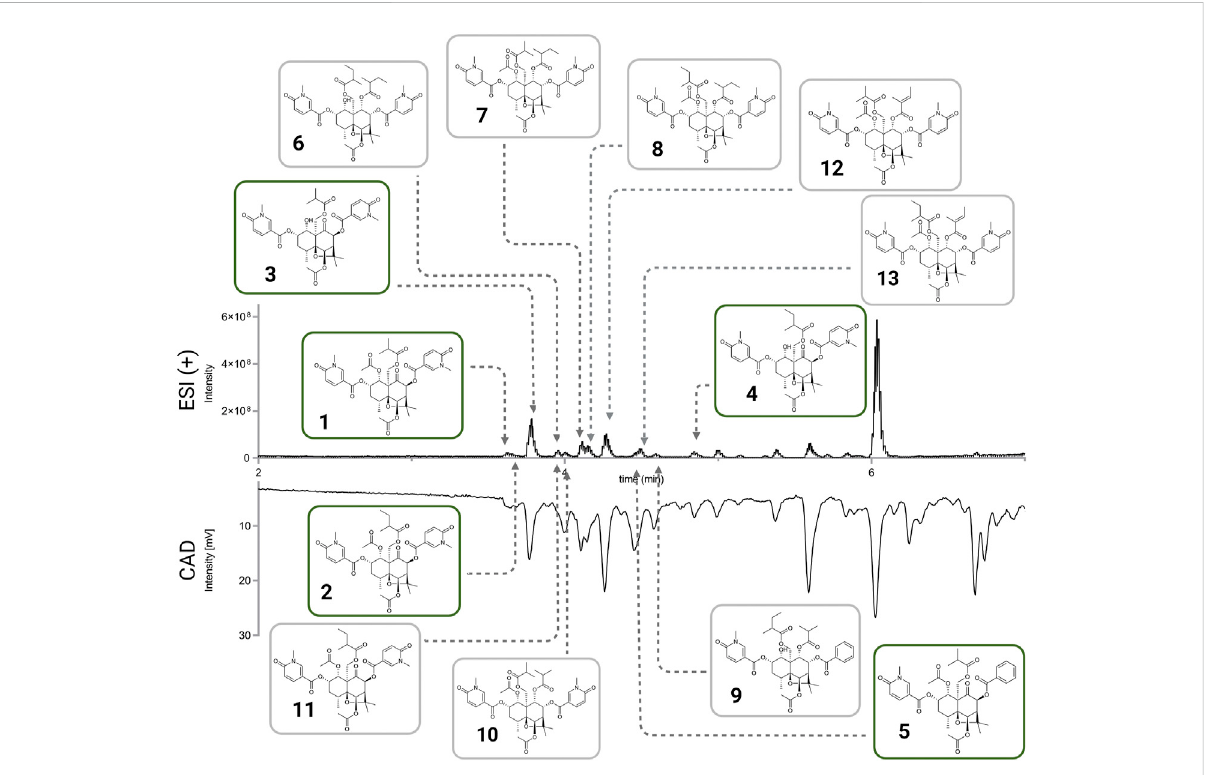
FIGURE 4 The relative position of the isolated compound ( 1 – 13 ) in the chromatogram for the ethyl acetate extract of Pristimera indica roots. The upper chromatographic trace corresponds to the ESI in positive ionization mode, while the lower trace corresponds to the Charged Aerosol Detector (CAD), a semi-quantitative trace. Compounds highlighted in green hold a new 9-oxodihydro- β -agarofuran base